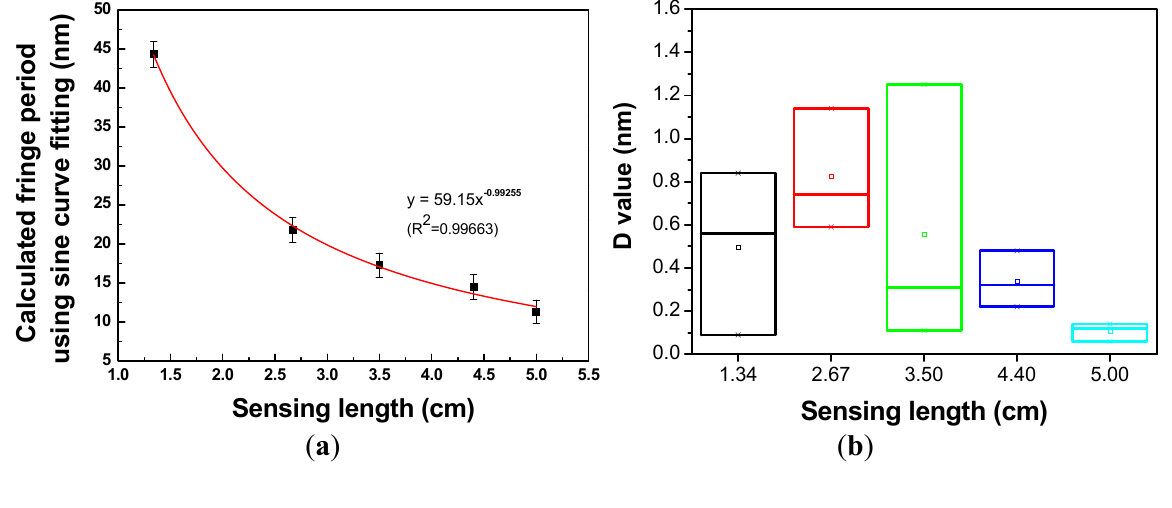
Figure 7. ( a ) Plot of calculated fringe periods from sine curve fitting versus sensing length; ( b ) Plot of D value versus sensing